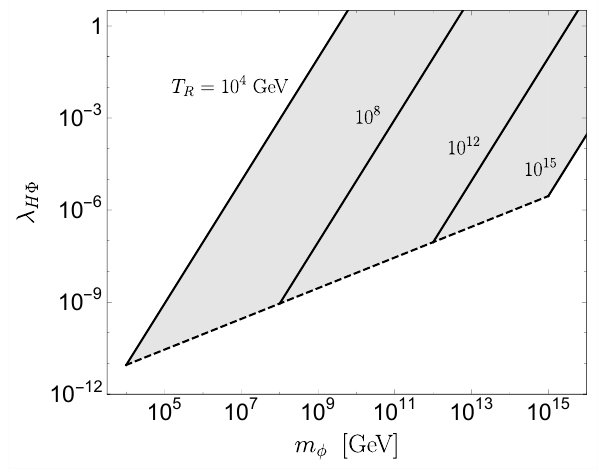
Figure 6 . The parameter space in the ( m (cid:30) ; (cid:21) H (cid:8) ) plane explaining the DM relic by the TeV scale Majoron. See the text for